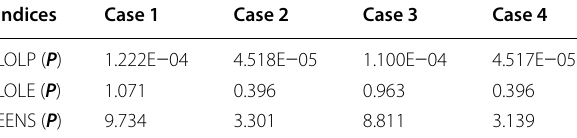
Table 2 Analysis of CPR adjustment in different cases